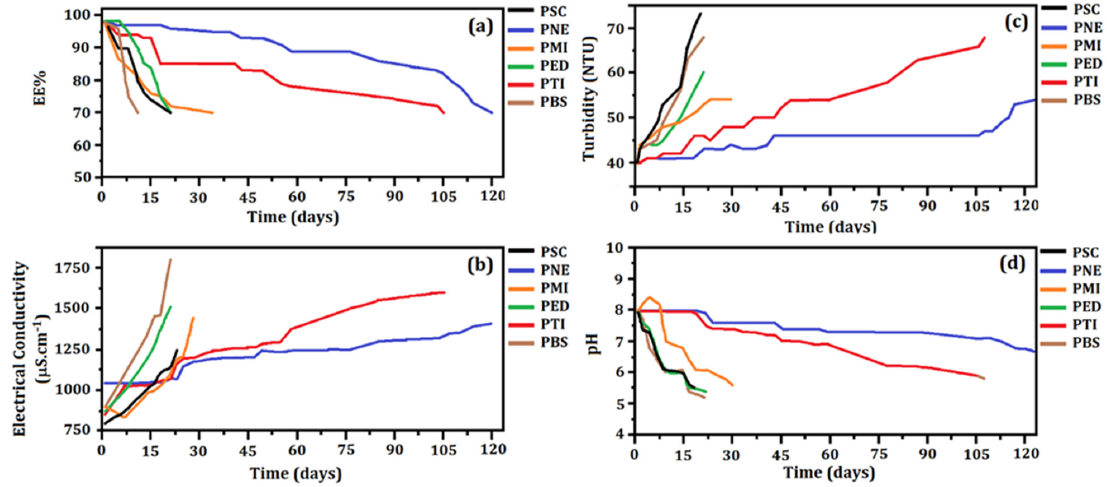
Figure 3. ( a ) Encapsulation Efficiency (EE%), ( b ) electrical conductivity, ( c ) turbidity and ( d ) pH of the loaded systems containing preservatives as a function of time (days).